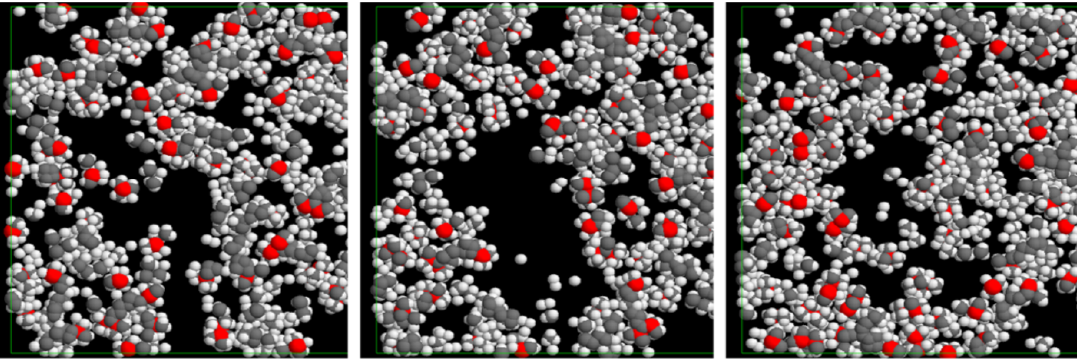
Figure 6. Visualization of free volume in PTCNSi 2 g. The density is 0.8470 g/cm 3 [15]. Successive slices in the range 0–10.5 Å.